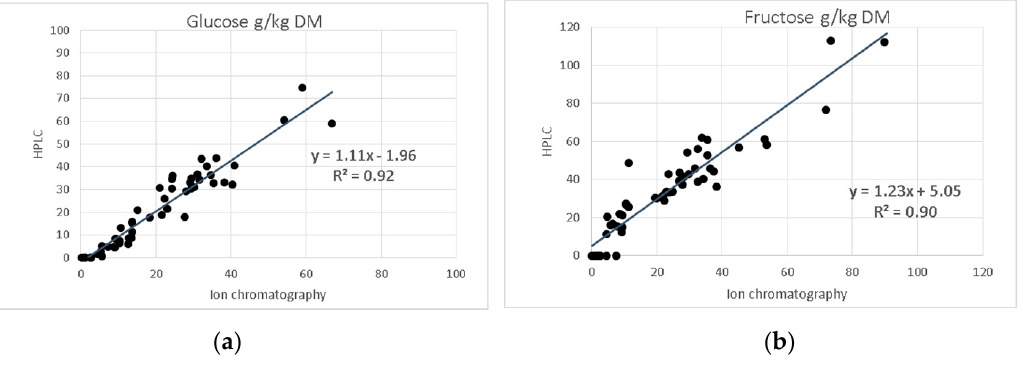
Figure 5. Correlation between the concentrations of glucose ( a ) and fructose ( b ), analysed by HPLC-RID and ion chromatography ( n = 54).